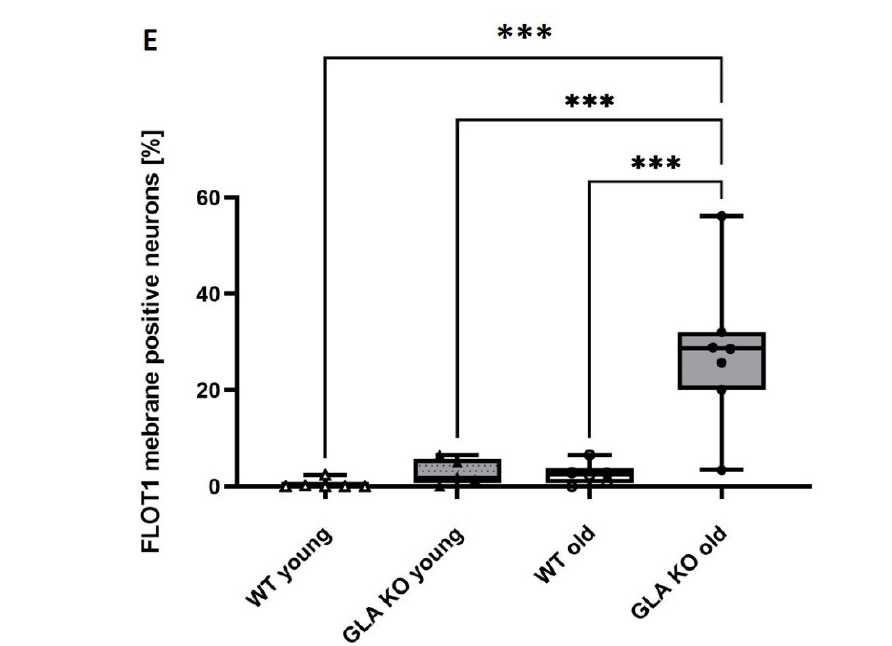
Figure 7. FLOT1 distribution analysis in murine DRG neurons. ( A – D ) Representative photomicrographs of FLOT1 distribution in murine DRG neurons. ( A ) Granular cytosolic FLOT1 distribution in DRG neurons of young ( A ) and old ( B ) WT mice (empty arrowheads). Mixed FLOT1 distribution represented as granular cytosolic signal (empty arrowheads) and membranous signal (full arrowheads) in DRG neurons of young GLA KO ( C ). Predominantly membranous FLOT1 distribution in DRG neurons of old GLA KO mice ( D ). Quantification of FLOT1-positive DRG neurons of young WT ( (cid:52) , n = 6); young GLA KO ( (cid:78) , n = 5), old WT ( , n = 6), and old GLA KO ( • , n = 7) mice displaying a membranous distribution pattern ( E ). Abbreviations: DRG = dorsal root ganglia; FLOT1 = flotillin-1; GLA KO = alpha-galactosidase A knockout; WT = wildtype. Scale bar: 100 µm. *** p < 0.001.